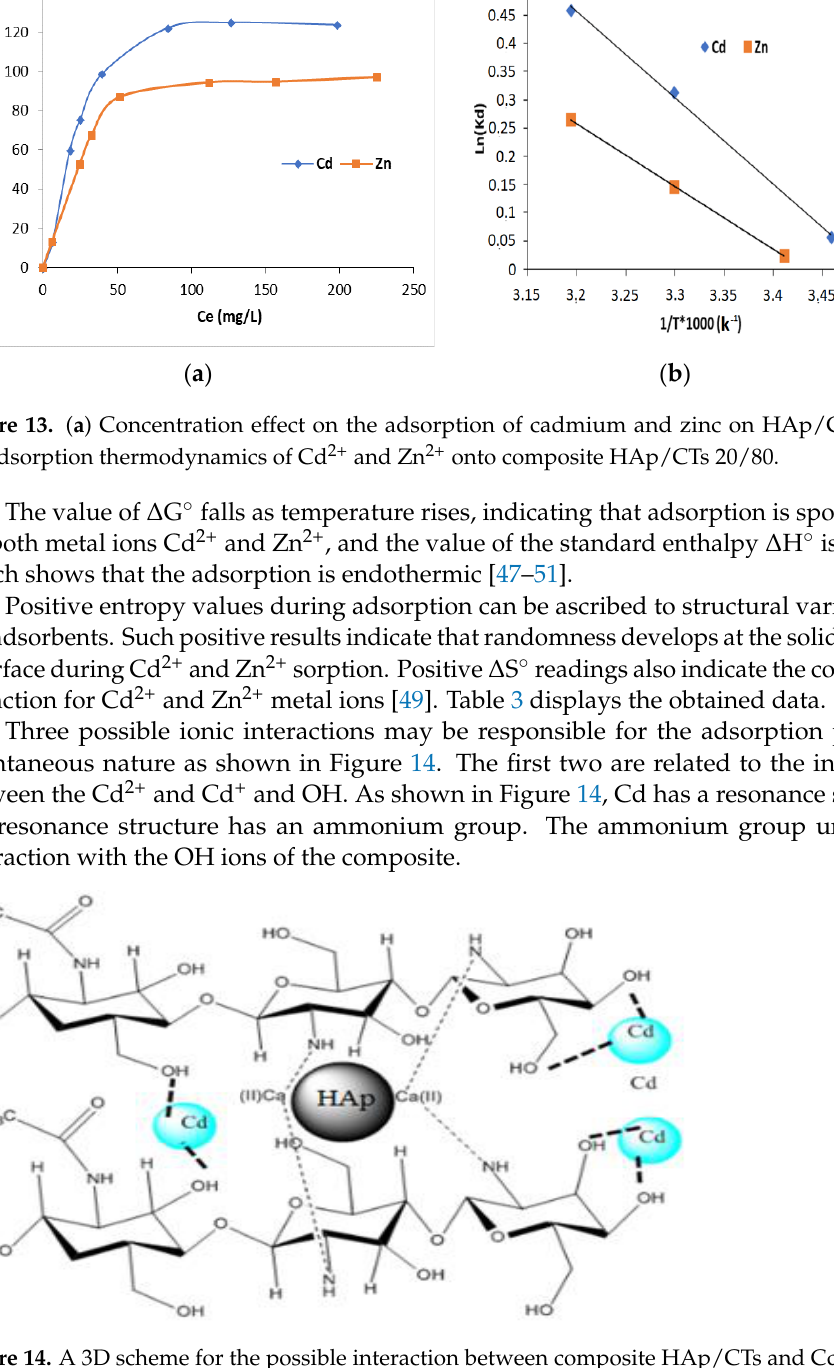
Figure 14. A 3D scheme for the possible interaction between composite HAp/CTs and Cd +2